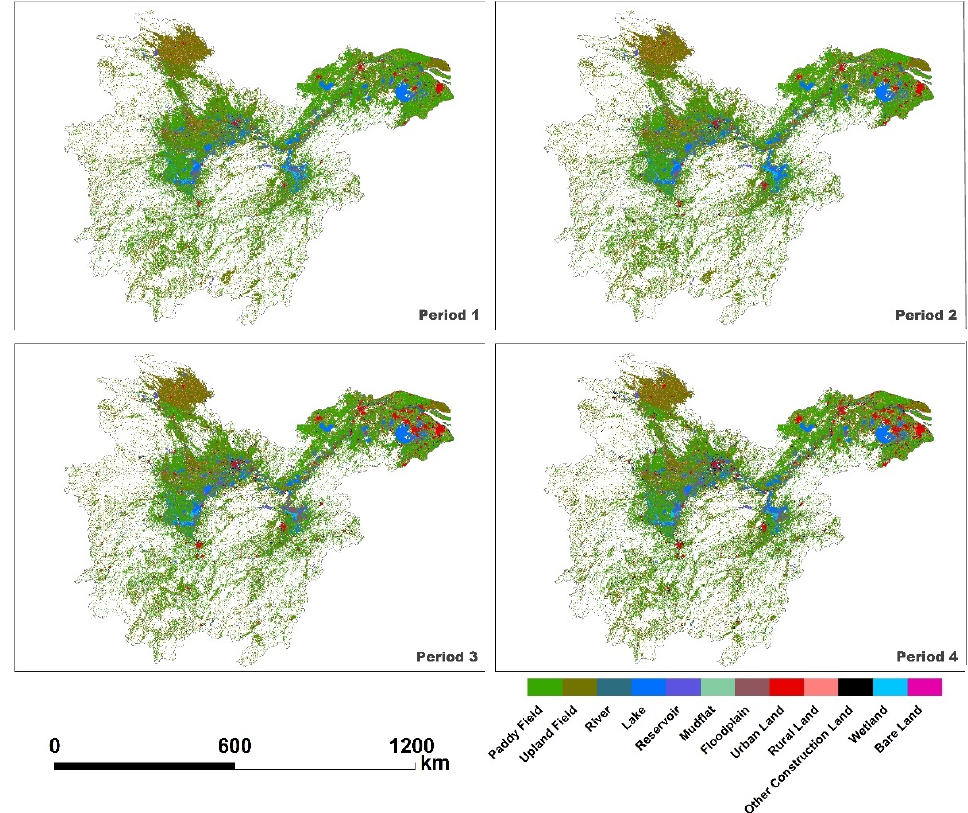
Figure A1. Land use in four periods. Period 1 is 2000; Period 2 is 2005; Period 3 is 2010; Period 4 is 2015.